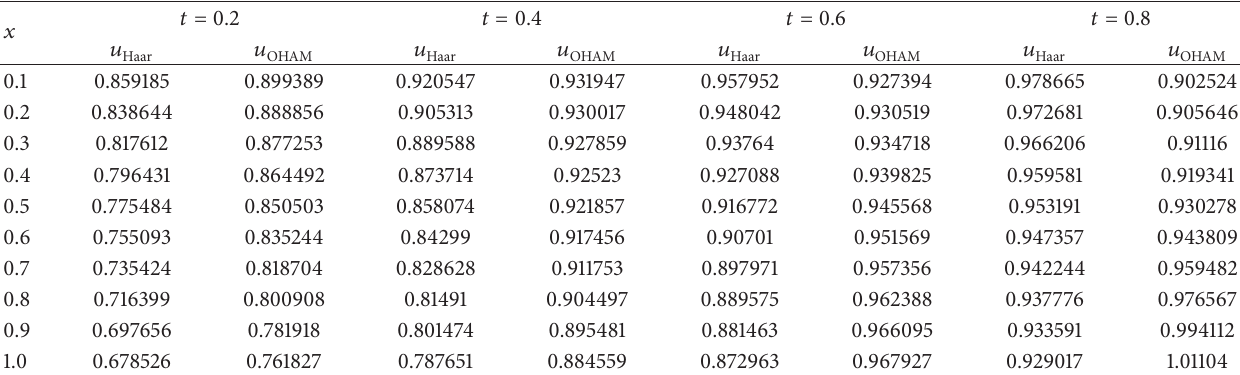
Table 6: The approximate solutions of generalized Fisher equation (49) using Haar wavelet method and five terms for fourth-order OHAM with convergence control parameters 𝐶 1 = −0.649458 , 𝐶 2 = 0.053658 , 𝐶 3 = −0.1822726 , 𝐶4 = 0.0894301 at various points of 𝑥 and 𝑡 for 𝛼 = 0.75